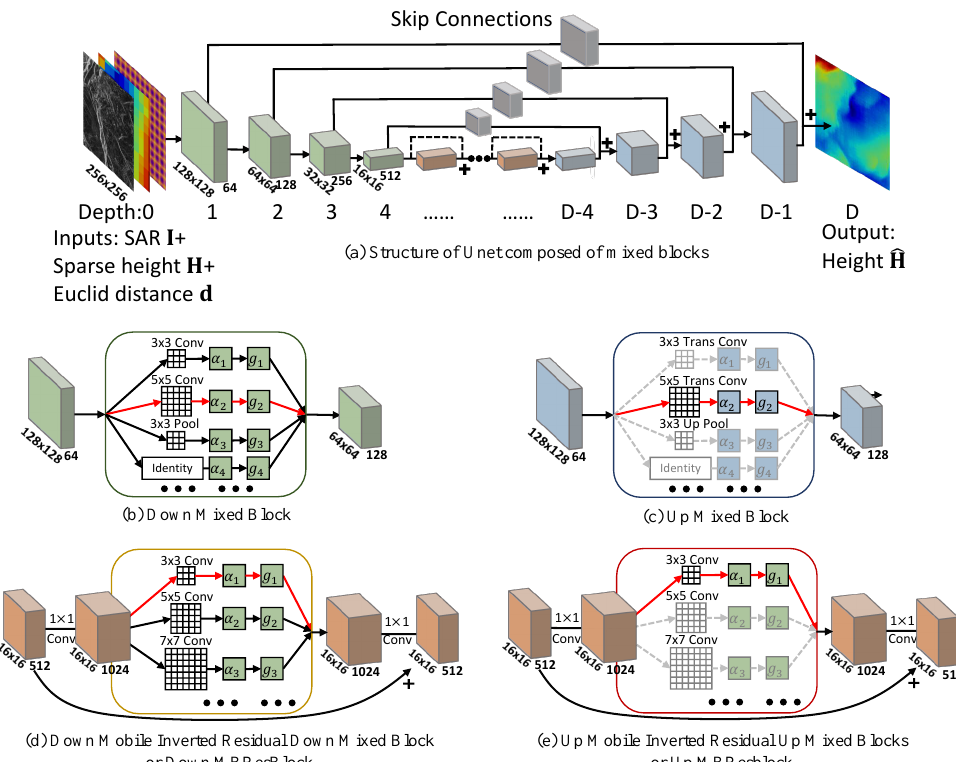
Figure 3. Network structure of PDNAS for Unet composed of down/up mixed blocks and down/up MBResblocks. Each mixed block contains a set of candidate operations, including 3 × 3, 5 × 5 convolution/transposed convolution,